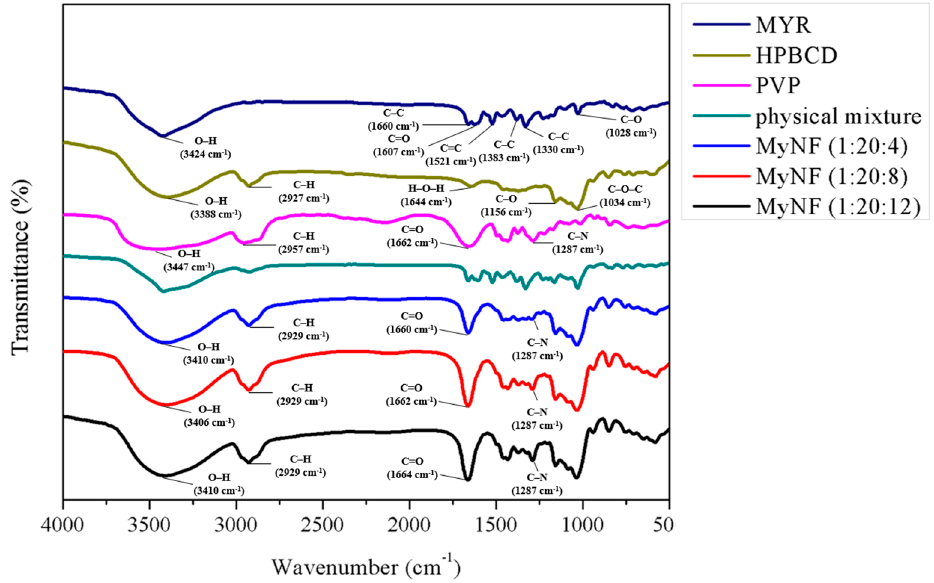
Figure 5. Fourier-transform infrared (FTIR) spectra of MYR, HPBCD, PVP, and physical mixture (MYR, PVP, and HPBCD powder), with different ratios of MyNF (MYR: HPBCD: PVP; 1: 20: 4, 1: 20: 8, and 1: 20: 12; w / w / w ).